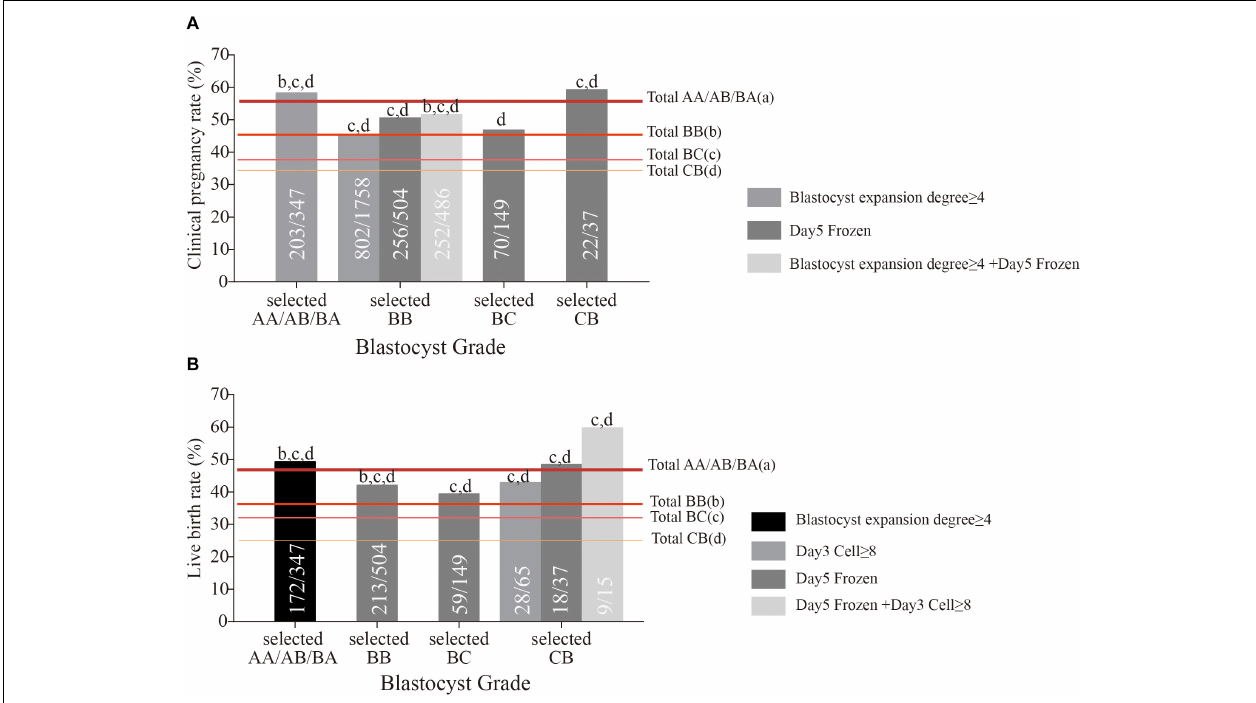
FIGURE 2 | The clinical pregnancy rate (A) and live birth rate (B) of selected AA/AB/BA, BB, BC, and CB grade blastocysts based on positive reference of cleavage-stage embryo quality and embryo development. The letters above the column represent that the clinical pregnancy outcomes of selected grade blastocysts had a significant difference ( P < 0.05) with total AA/AB/BA (a), BB (b), BC (c), and CB (d) grade